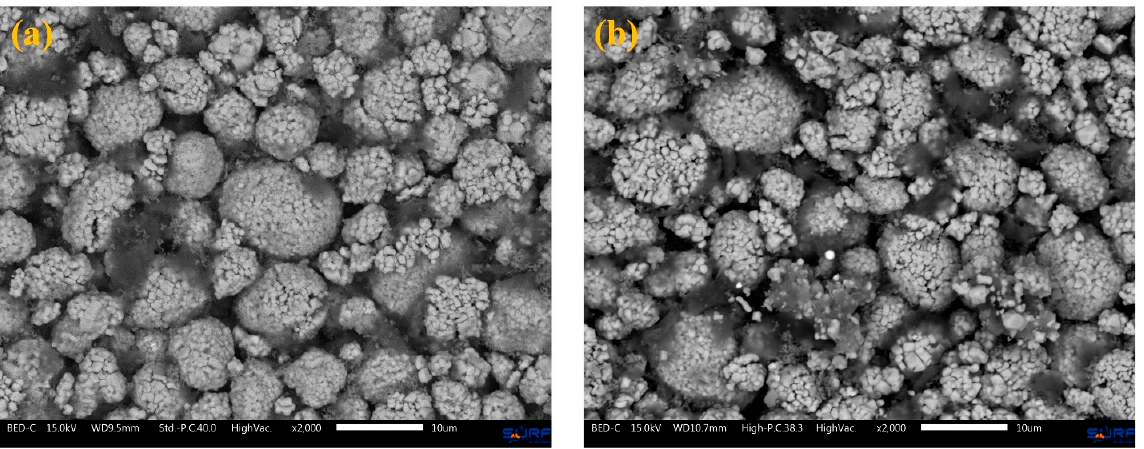
Figure 6. Local SEM images from harvested samples of ( a ) new NMC cell, and ( b ) aged NMC cell.